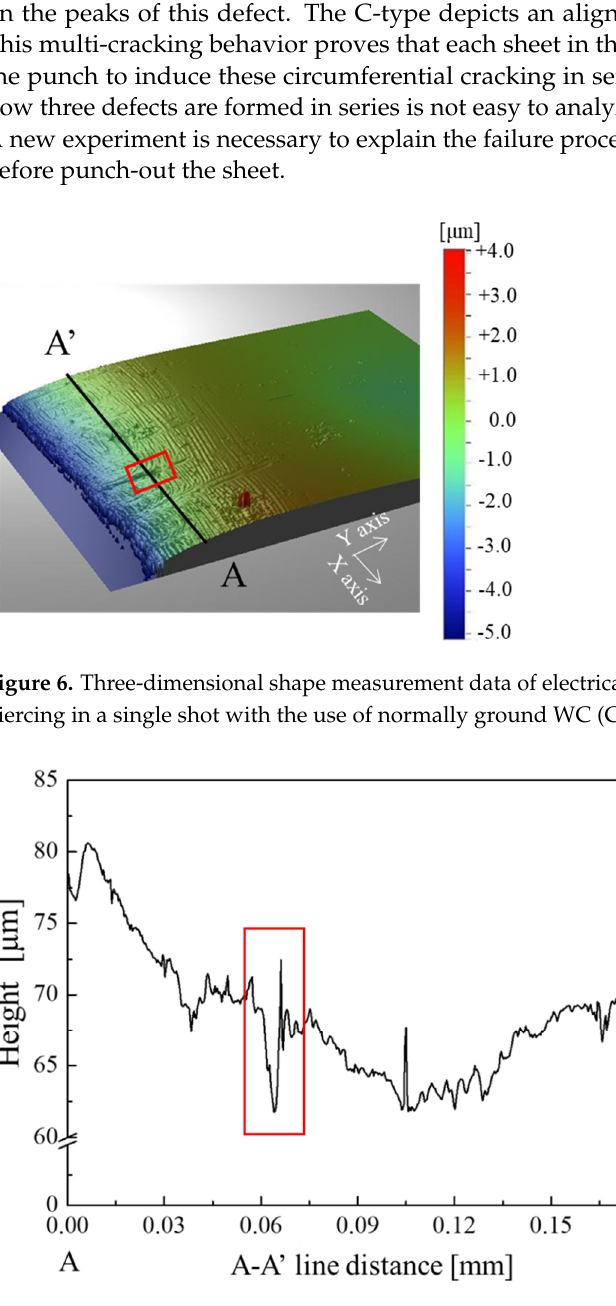
Figure 8. Microstructure damages of electrical amorphous steel sheet induced by piercing in a single shot with the use of the diamond-coated punch. Figure 9 shows the comparison of the damaged zone width in five pierced electrical amorphous steel sheets of work between two punches. At the number 1 sheet, even when using the normally ground WC (Co) punch (WC (Co) punch), W defect = W A + W B + W C = 9  m, lower than that W defect = 18  m in using the laser-trimmed diamond-coated WC (Co) punch with the sharp edge and nanotextures (diamond punch). At the number 2 sheet, three defects were generated in the pierced brittle sheets by using the WC (Co) punch even with inhomogeneous sharp edge profile; e.g., the meas- ured damaged zone width is W defect = 80  m as shown in Figure 5. When using the punch with an inhomogeneous sharp edge profile, the work surface is radially compressed in